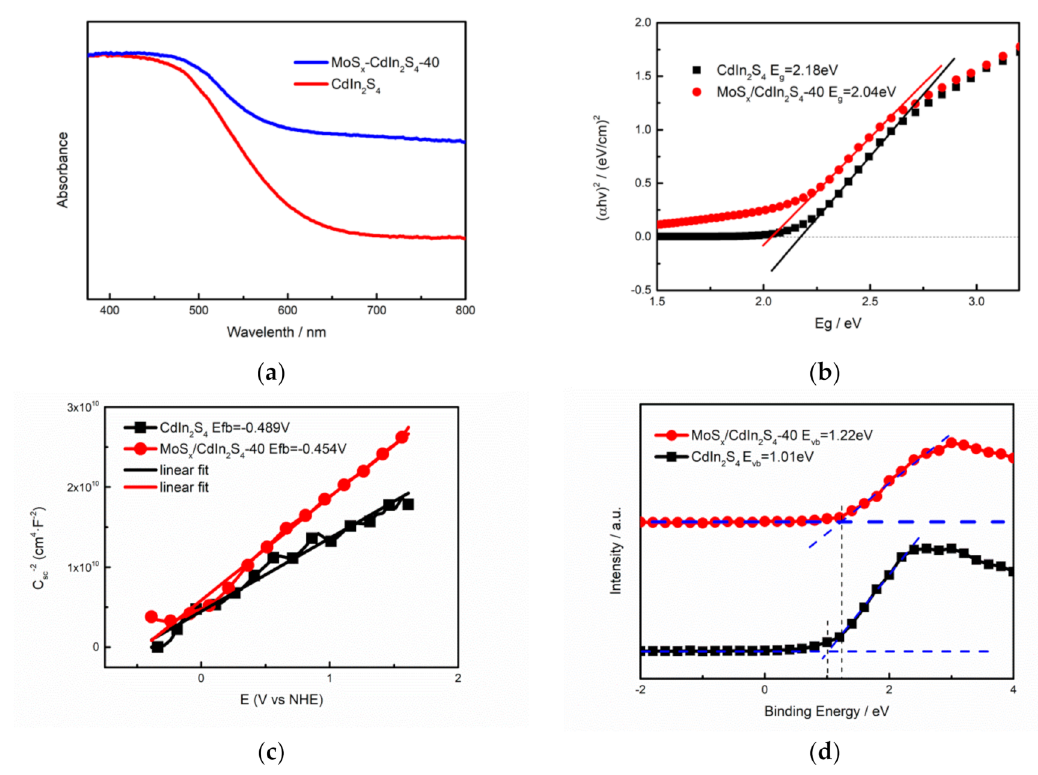
Figure 8. UV–Vis spectra ( a ), Tauc plots ( b ), Mott–Schottky plots ( c ), and XPS valence band spectra of CdIn 2 S 4 and MoS x / CdIn 2 S 4 ( d